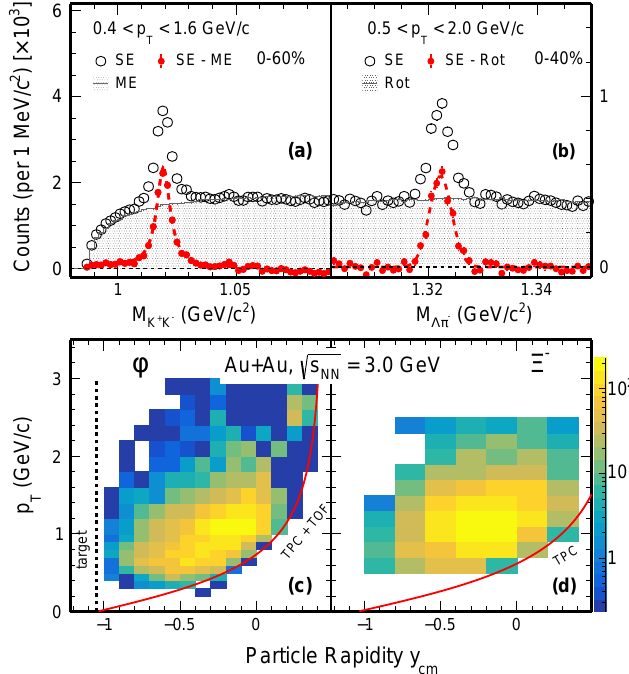
Figure 1: Invariant mass distributions of (a) K + K − and (b) Λ π − pairs reconstructed from data are shown on the top. The grey shaded histogram represents the normal- ized mixed-event (rotating daughters for Ξ − ) unlike-sign distribution that is used to estimate the combinatorial background. The transverse momentum ( p rapidity ( y ) for reconstructed (c) φ and (d) Ξ − are shown on the bottom. cm